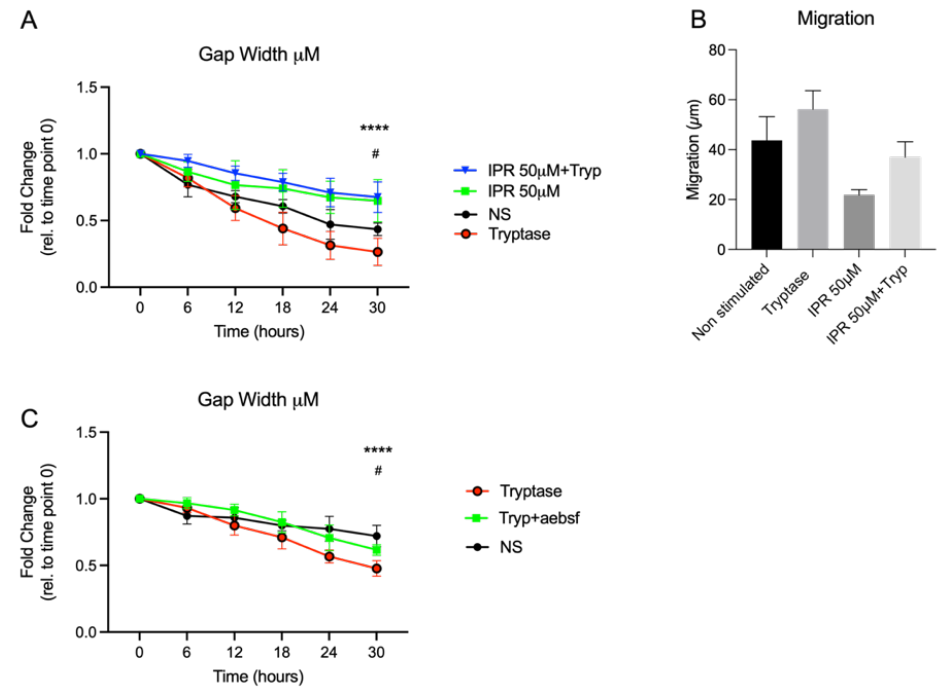
Figure 5. Live cell imaging revealed impaired gap closure ( A ) and migration ( B ) with the addition of uPA-uPAR inhibitor compared to non treated cells. The gap closure promoting effect of tryptase was reduced with the use of serine protease inhibitor AEBSF ( C ). Statistical significance between non-stimulated and chymase stimulated cells at different time points was tested using two-way ANOVA with Šidák’s multiple comparison test. Statistical significance between non-stimulated and tryptase stimulated cells and nonstimulated and chymase stimulated cells was tested using the Mann–Whitney test. Data represent mean (SD) and are based on 3 positions in one technical repeat. Nonstimulated vs. IPR # p < 0.05 tryptase vs. tryptase IPR + tryptase **** p < 0.0001. Nonstimulated vs. Tryptase # p < 0.05, tryptase vs. AEBSF + Tryptase **** p < 0.0001.